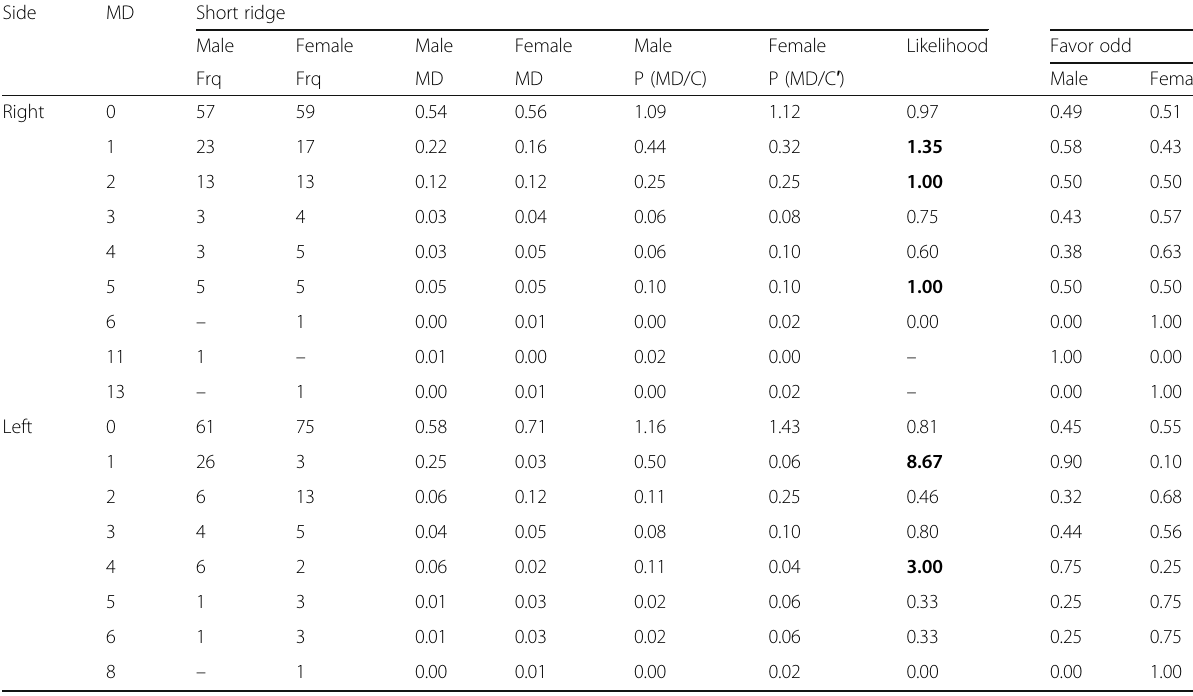
Table 4 Frequency, likelihood ratio and favor odd of different short ridge density of right and left thumbprints Side MD Short ridge